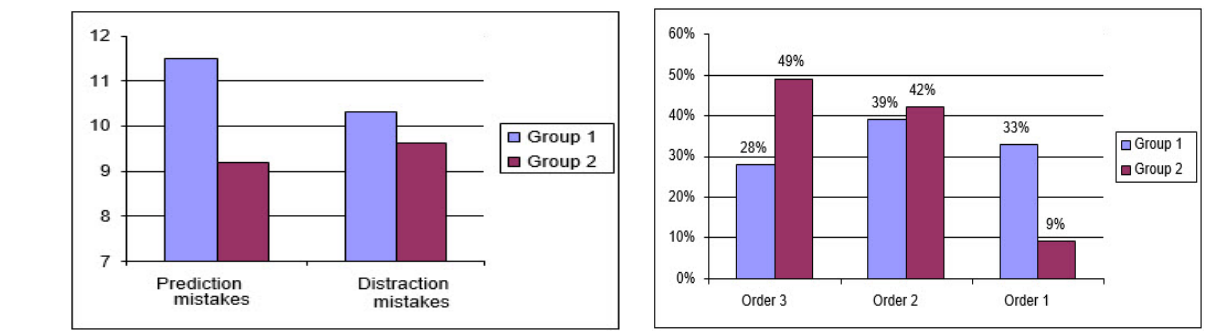
functions. Children in the correctional